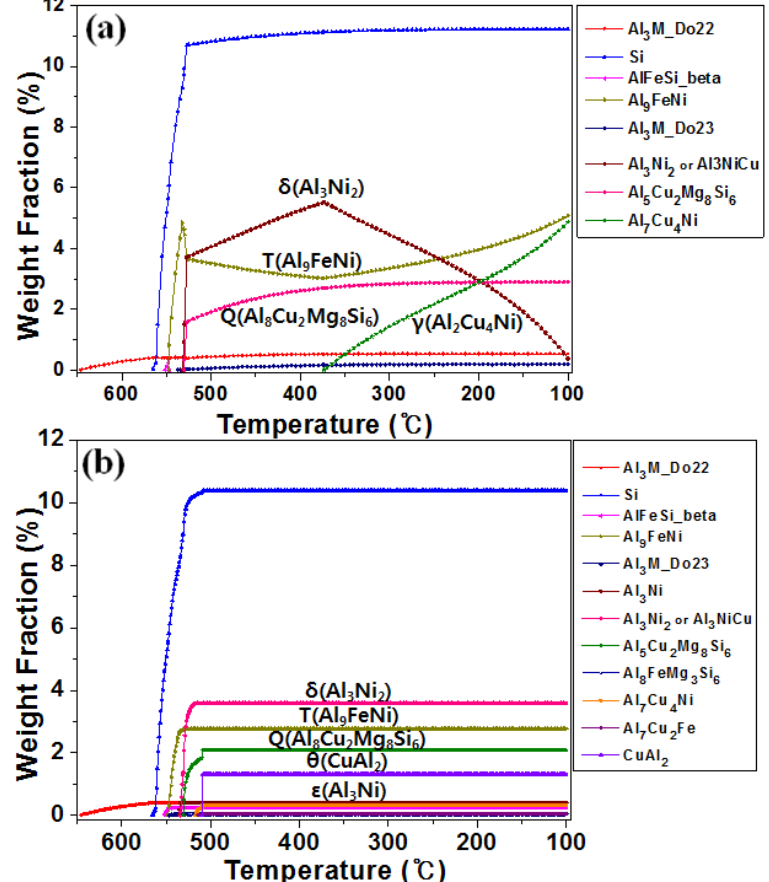
Figure 3. JMatPro simulation data of the as ‐ received alloy for ( a ) equilibrium; ( b ) non ‐ equilibrium state.